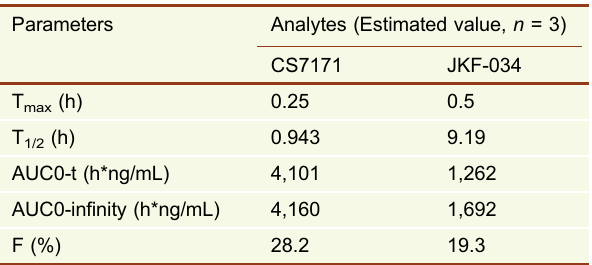
Table 3. Pharmacokinetic parameters of CS7171 and JKF-034 in CD1 mice. Parameters